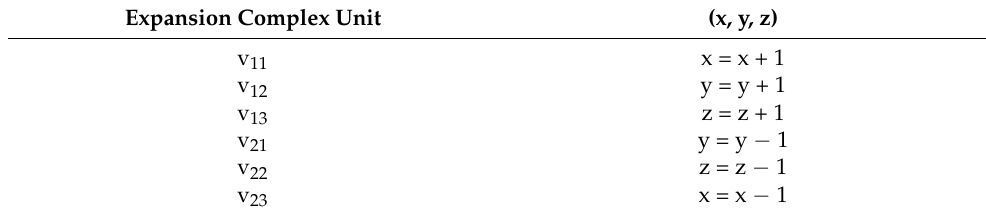
Table 2. Correspondence between the (x, y, z) value and the expansion complex unit.